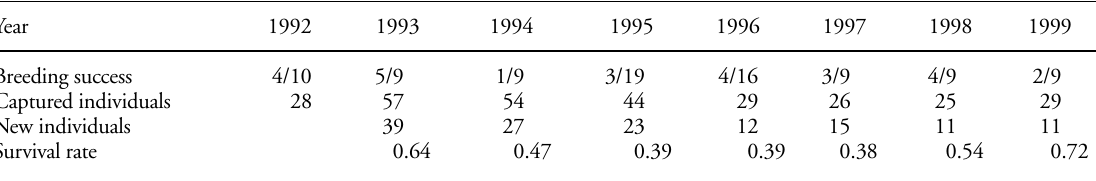
Table 1. Field data overview from 1992–1999 for the Brandberge study site. Breeding success shows the numbers of spawn strings where metamorphs emerged from versus the total number of strings. The survival rate given is a low estimate – averaged over all age classes – assuming all survivors of the preceding year being